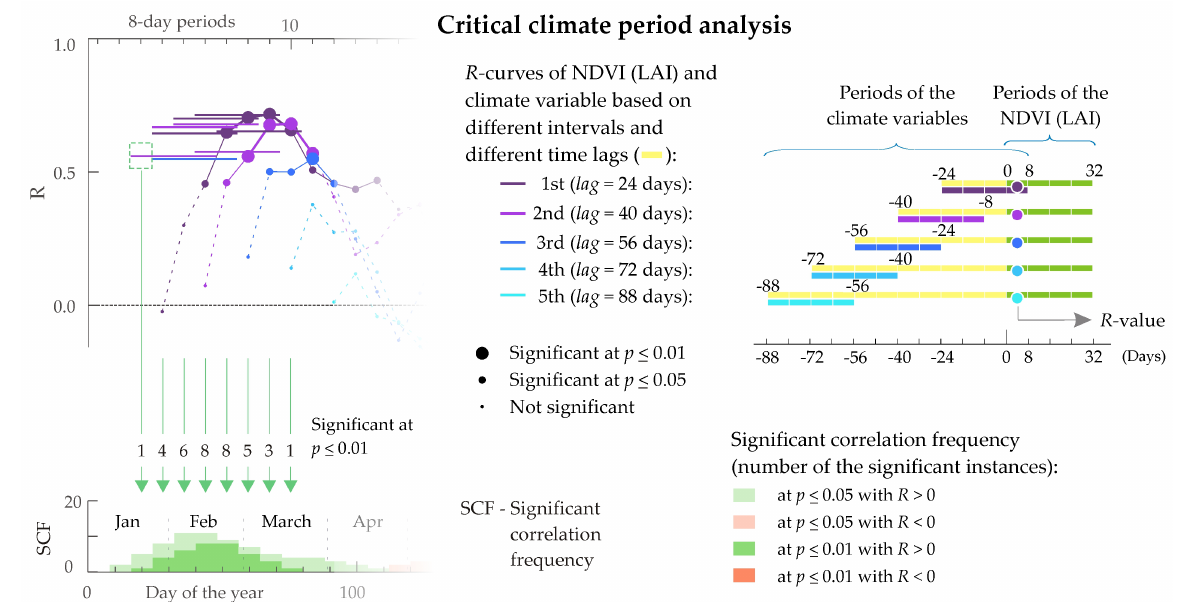
Figure 3. Methodology of the critical climate period analysis based on moving-window correlation. An example of the five R -curves used based on five different time lags is presented on the left. The different intervals of the climate variables relative to the interval of the vegetation state and the corresponding time lags between them are shown in the top right corner. One period is an 8-day long